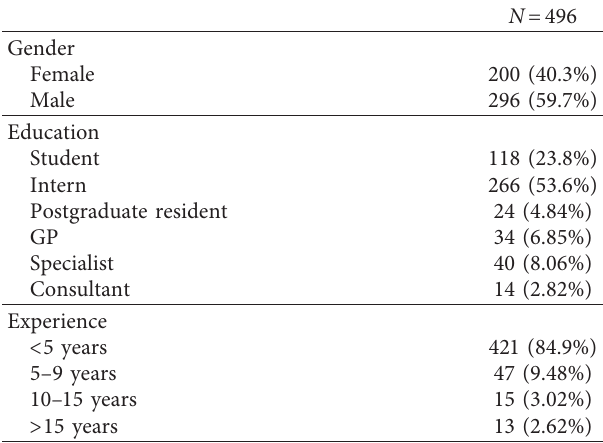
Table 1: Demographic characteristics of the study